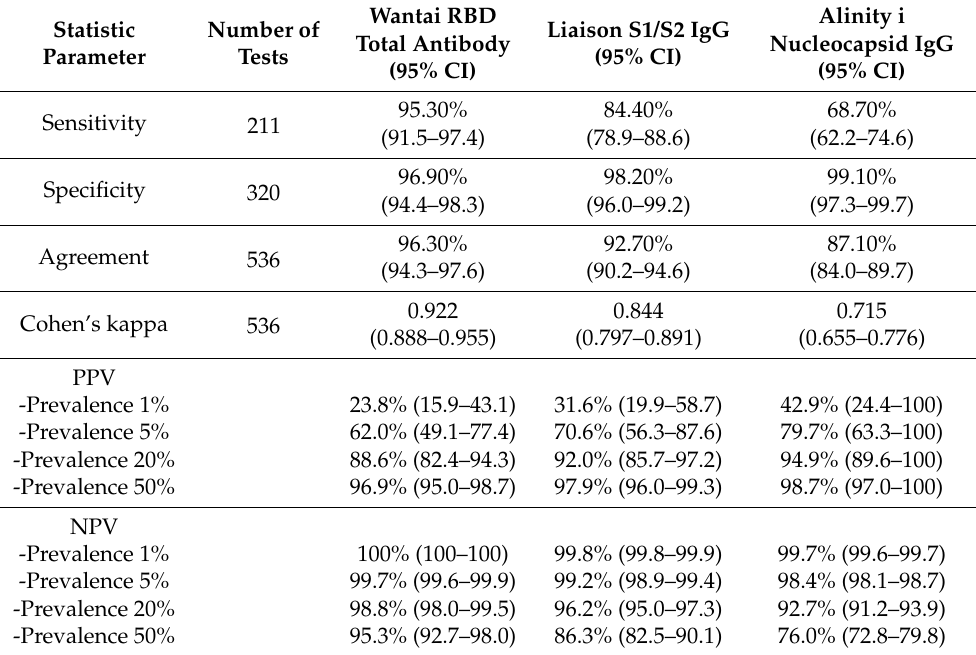
Table 3. Performances of the commercially available antibody tests when compared to the two-step reference